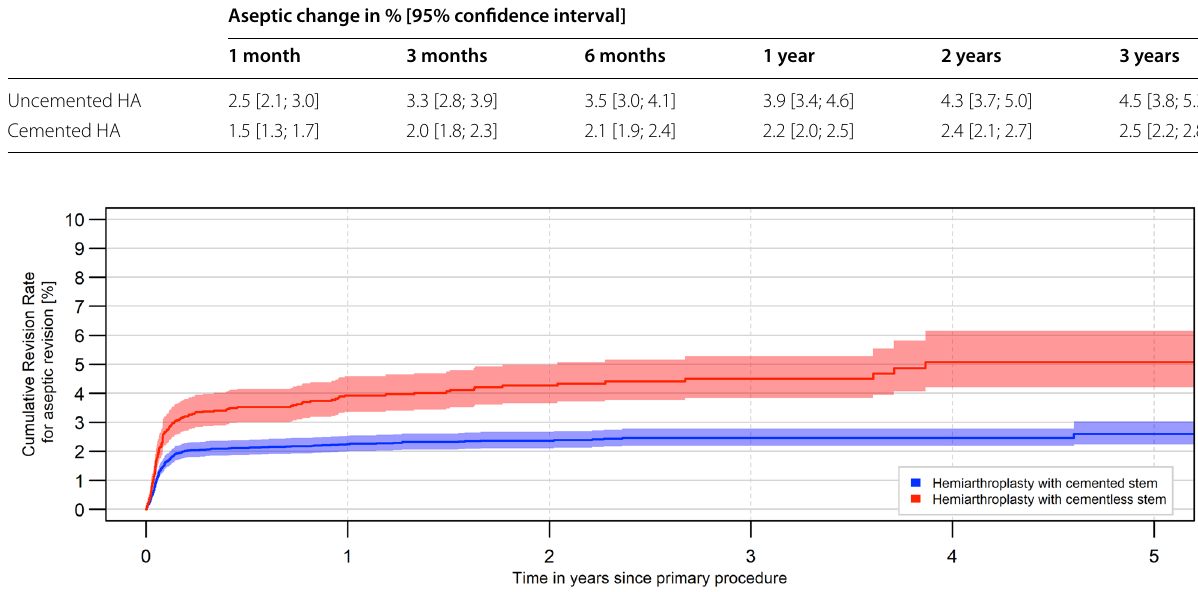
Fig. 2 Development of aseptic revisions within the first 5 years after implantation of cemented or uncemented hemiarthroplasty for the treatment of a femoral neck fracture (log-rank test: p <